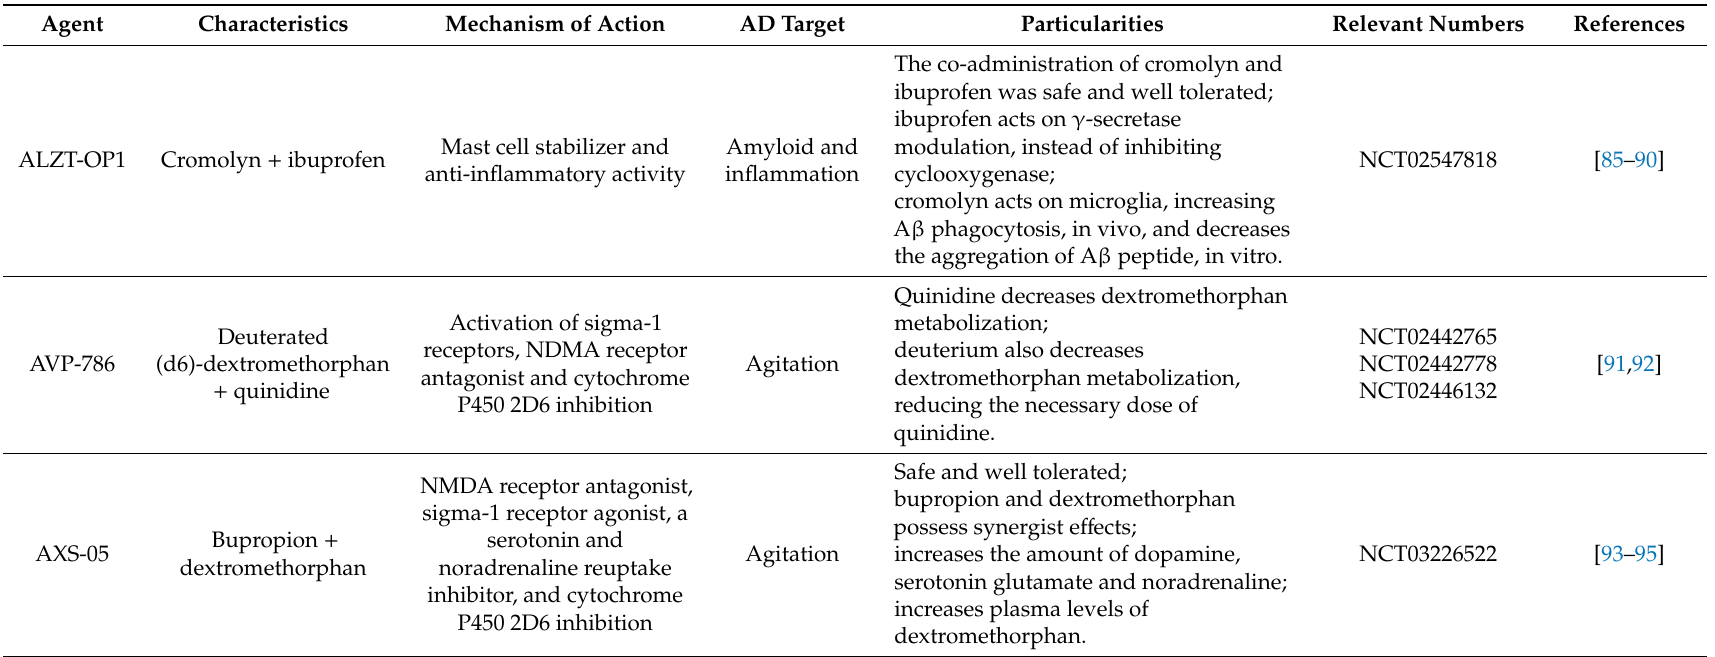
Table 2. Combination therapies in phase III clinical trials for AD treatment